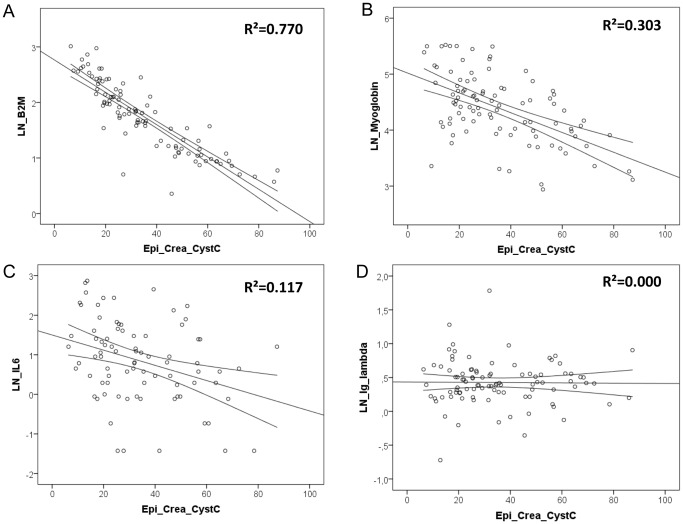
Dot plots with best fit linear regression lines for LN of LMWP’s in function of eGFR.Dot plots with best fit linear regression lines for natural logarithms of β2M, myoglobin, IL-6 and Ig-λ, as examples of strongly, moderately and weakly correlating low molecular weight proteins, in function of estimated Glomerular Filtration Rate, calculated by CKD-EPI-Crea-CystC. The dots represent the individual concentrations and the lines the best fit linear regression line with the 95% confidence interval. LN: natural logarithm, LMWP: low molecular weight protein, β2M : beta-2- microglobulin, IL-6: Interleukin-6, Ig-λ: immunoglobulin light chain lambda, EPI-Crea-CystC: CKD-EPI formula based on serum creatinine and Cystatin C, R2: regression coefficient, LN: natural logarithm.